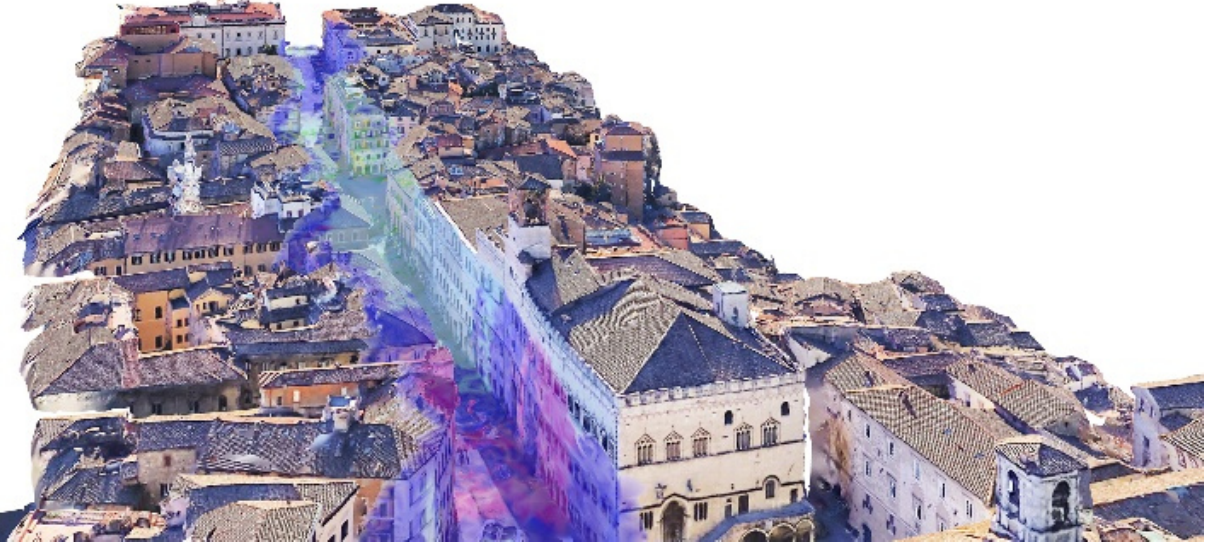
Figure 6 - Representation of emotions through mesh.